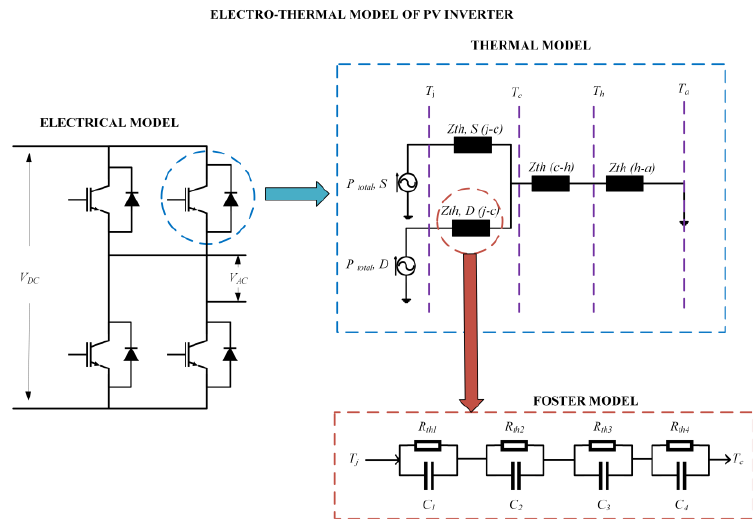
Figure 5. Electro-thermal model of a PV inverter.